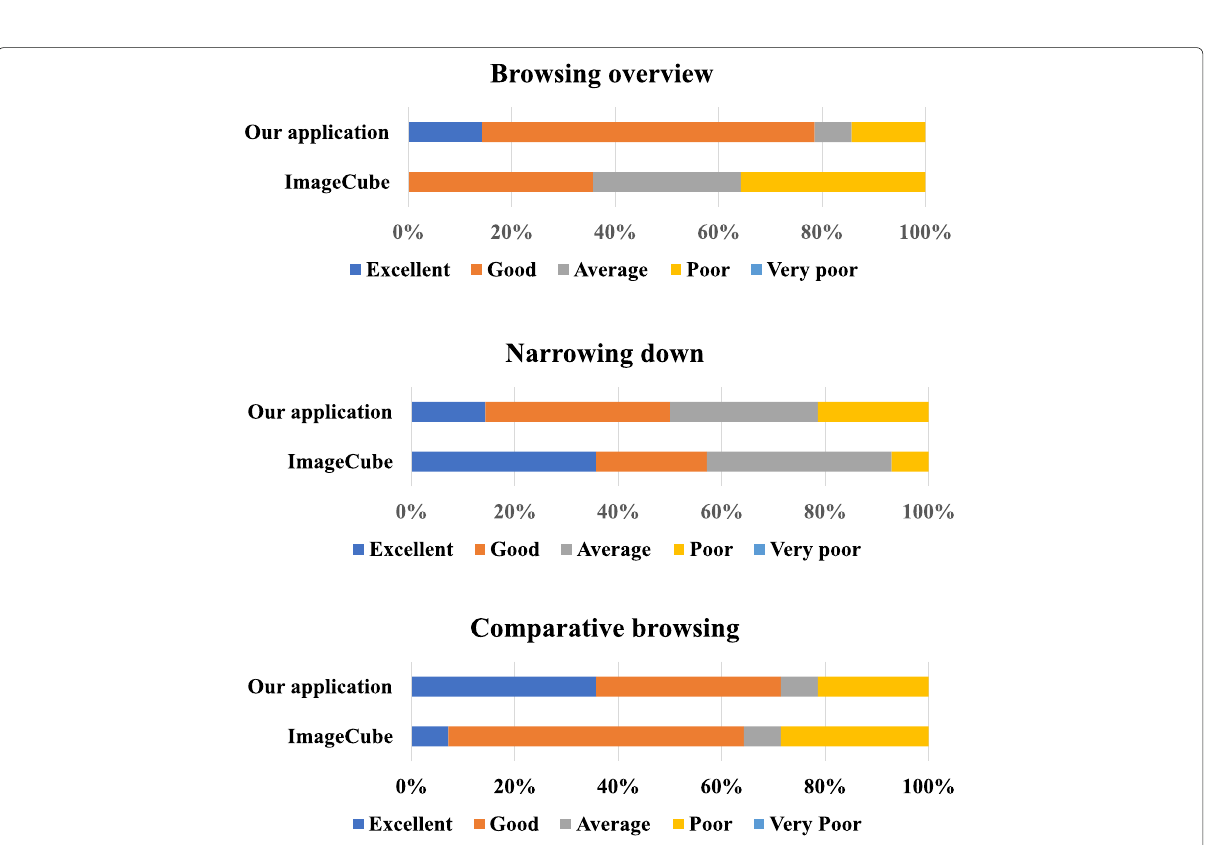
Fig. 10 User evaluation results of the application for painting image